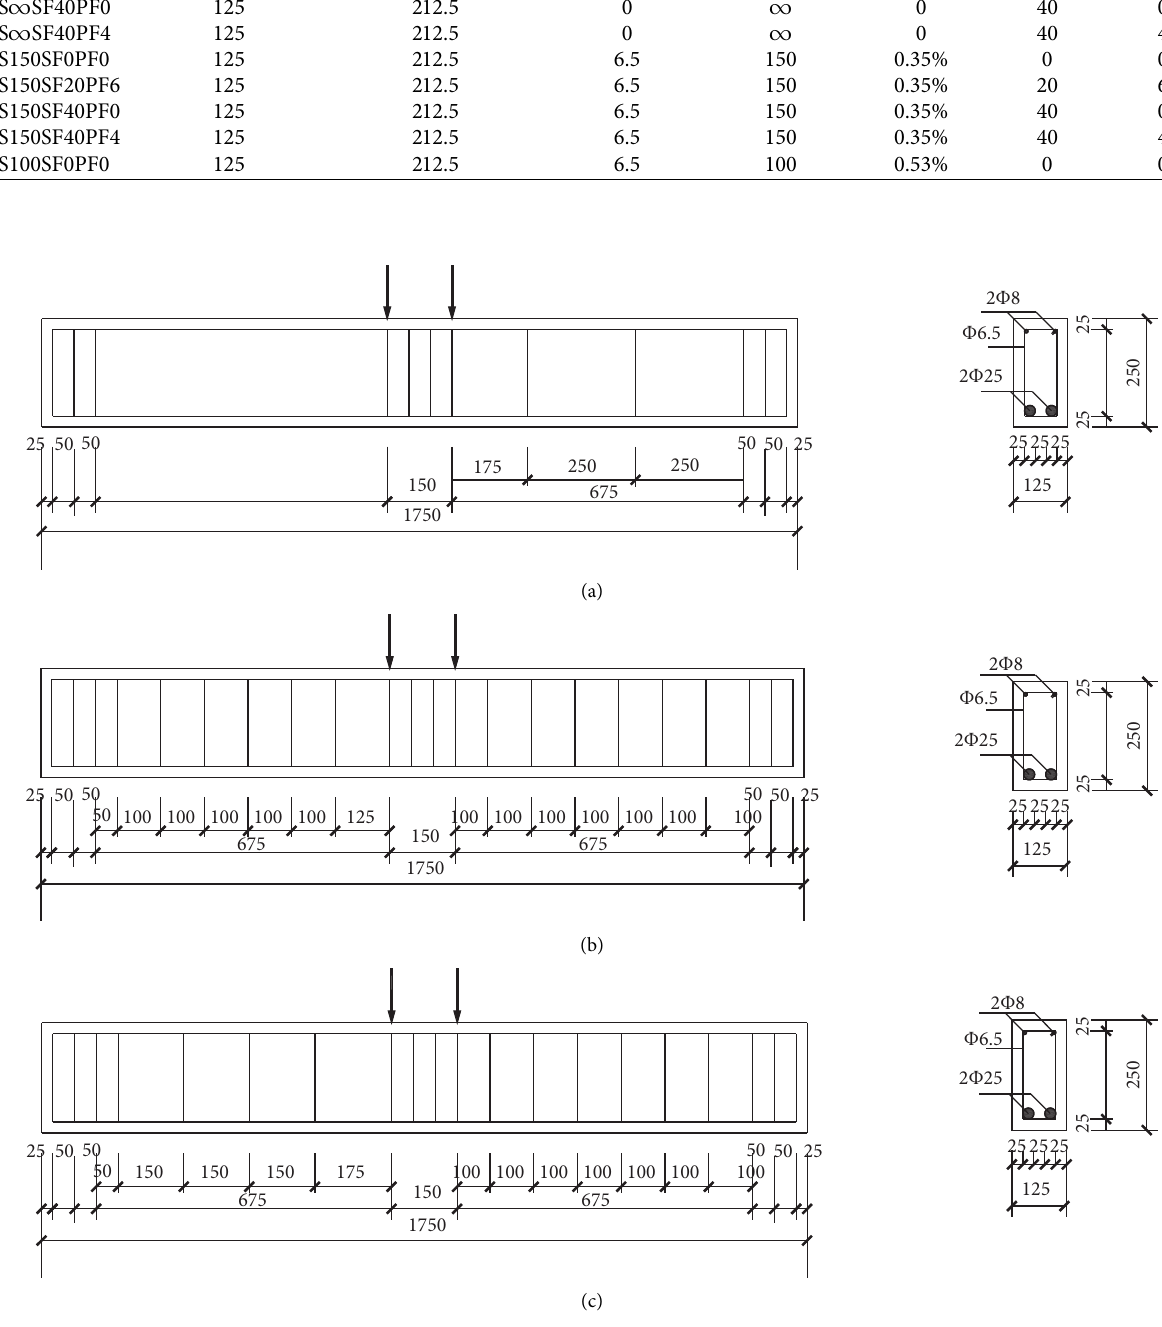
Figure 1: Geometry and reinforcement details of rectangular beams. (a) Stirrup ratio 0% (without stirrup). (b) Stirrup ratio 0.53% (SS100). (c) Stirrup ratio 0.35%